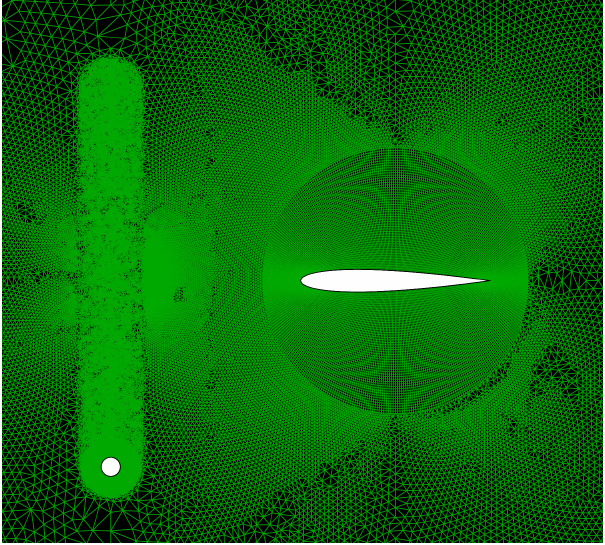
Figure 8. Closed-view of mesh motion by applying sinusoidal oscillation to the